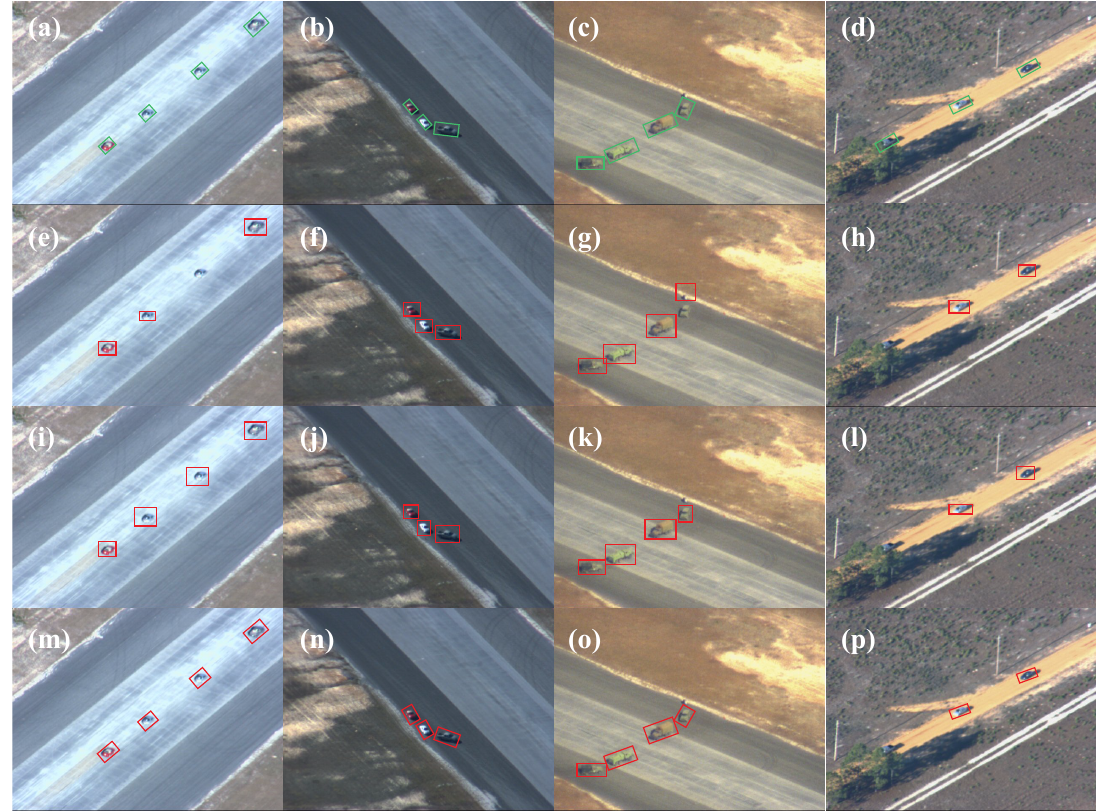
Figure 6. Comparison of the detection results for the VIVID data set. ( a – d ): The ground truth, ( e – h ): Fast convolutional neural network (Fast-CNN) module, ( i – l ): YOLOv3 module, ( m – p ): Improved YOLOv3